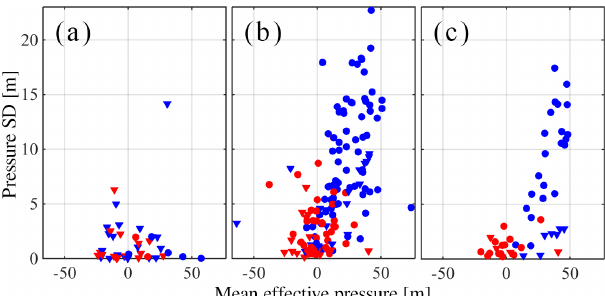
Figure 7. Scatter plots of mean effective pressure and water pres- sure standard deviation for (a) mechanical cluster M1, (b) hydraulic cluster H1, and (c) a 6d window on hydraulic cluster H1; this time window corresponds to window f defined in Figs. 10 and 11f. In all panels, each point represents a borehole within the cluster. Bore- holes that display diurnal variations that are in phase with each other (i.e., belong to the same subcluster) are shown in the same colour. Boreholes are plotted as circles if located in the northern half of the study area or as triangles